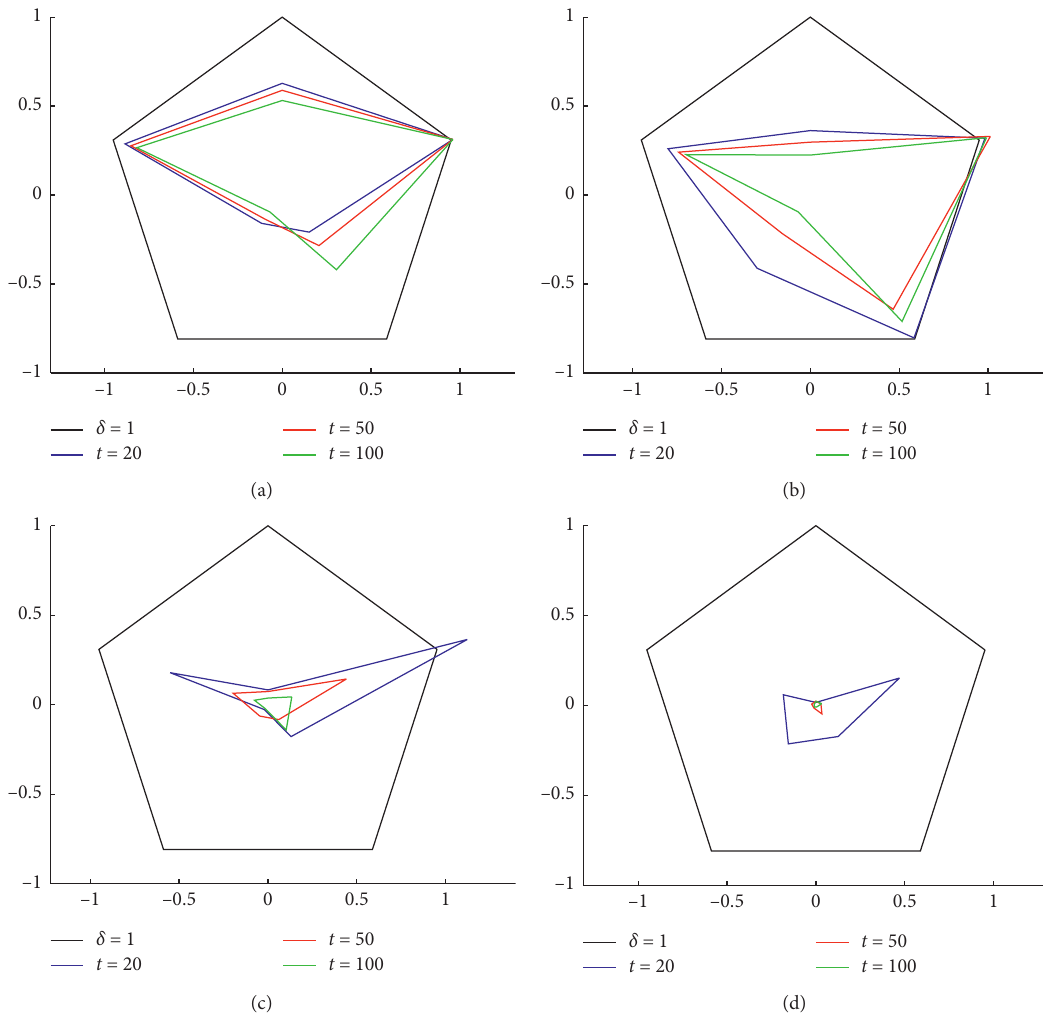
Figure 3: The relative errors of each element in the parameter vector. (a) SG. (b) TI-SG. (c) MT-SG. (d) MMG.